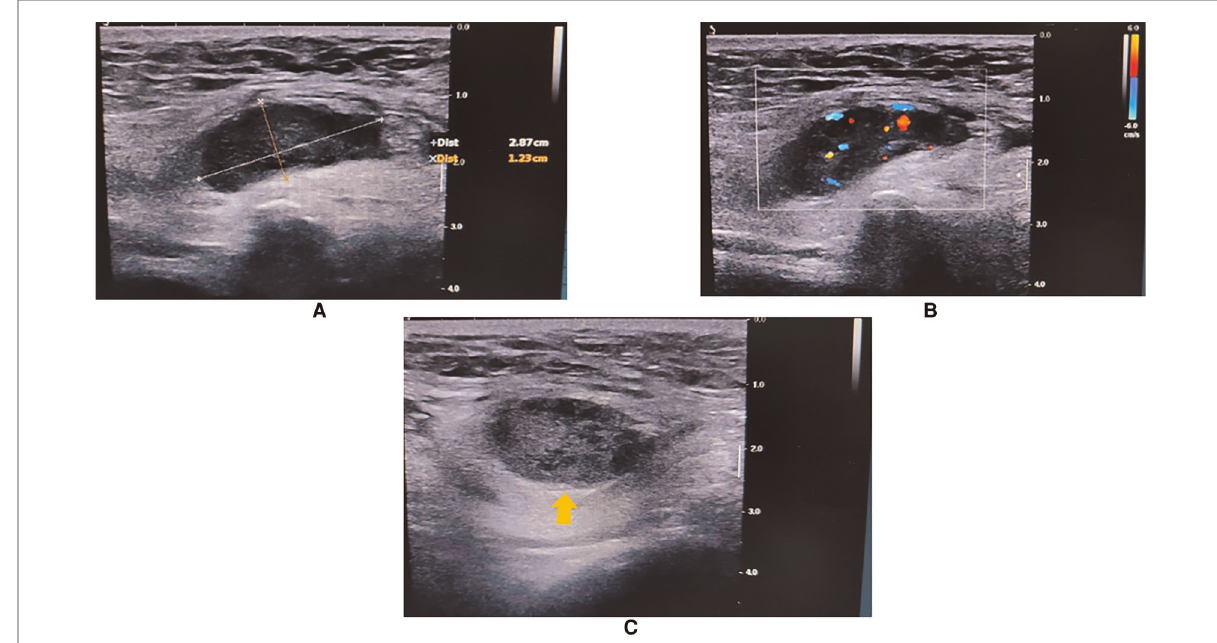
FIGURE 1 Inguinal US showing a 2.9× 1.2 cm solid-cystic mass in the right inguinal region (arrow head). The spermatic cord was swollen with a high echo. ( A ) Long-axis view. ( B ) Color Droppler mode showing blood fl ow signals within the mass. ( C ) Short-axis